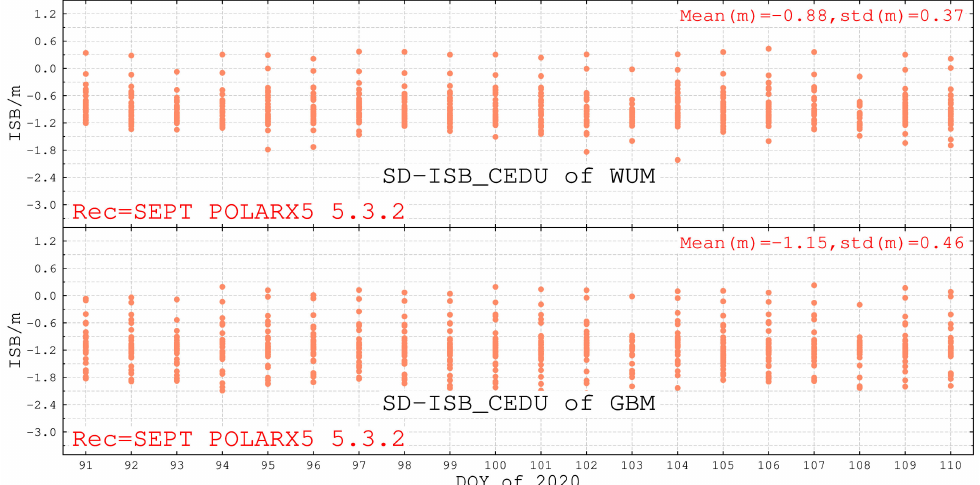
Figure 11. The single di ff erence ISB series of SEPT POLARX5 5.3.2 by using GBM and WUM precise products from DOY 091 to 110, 2020. Reference station: CEDU.